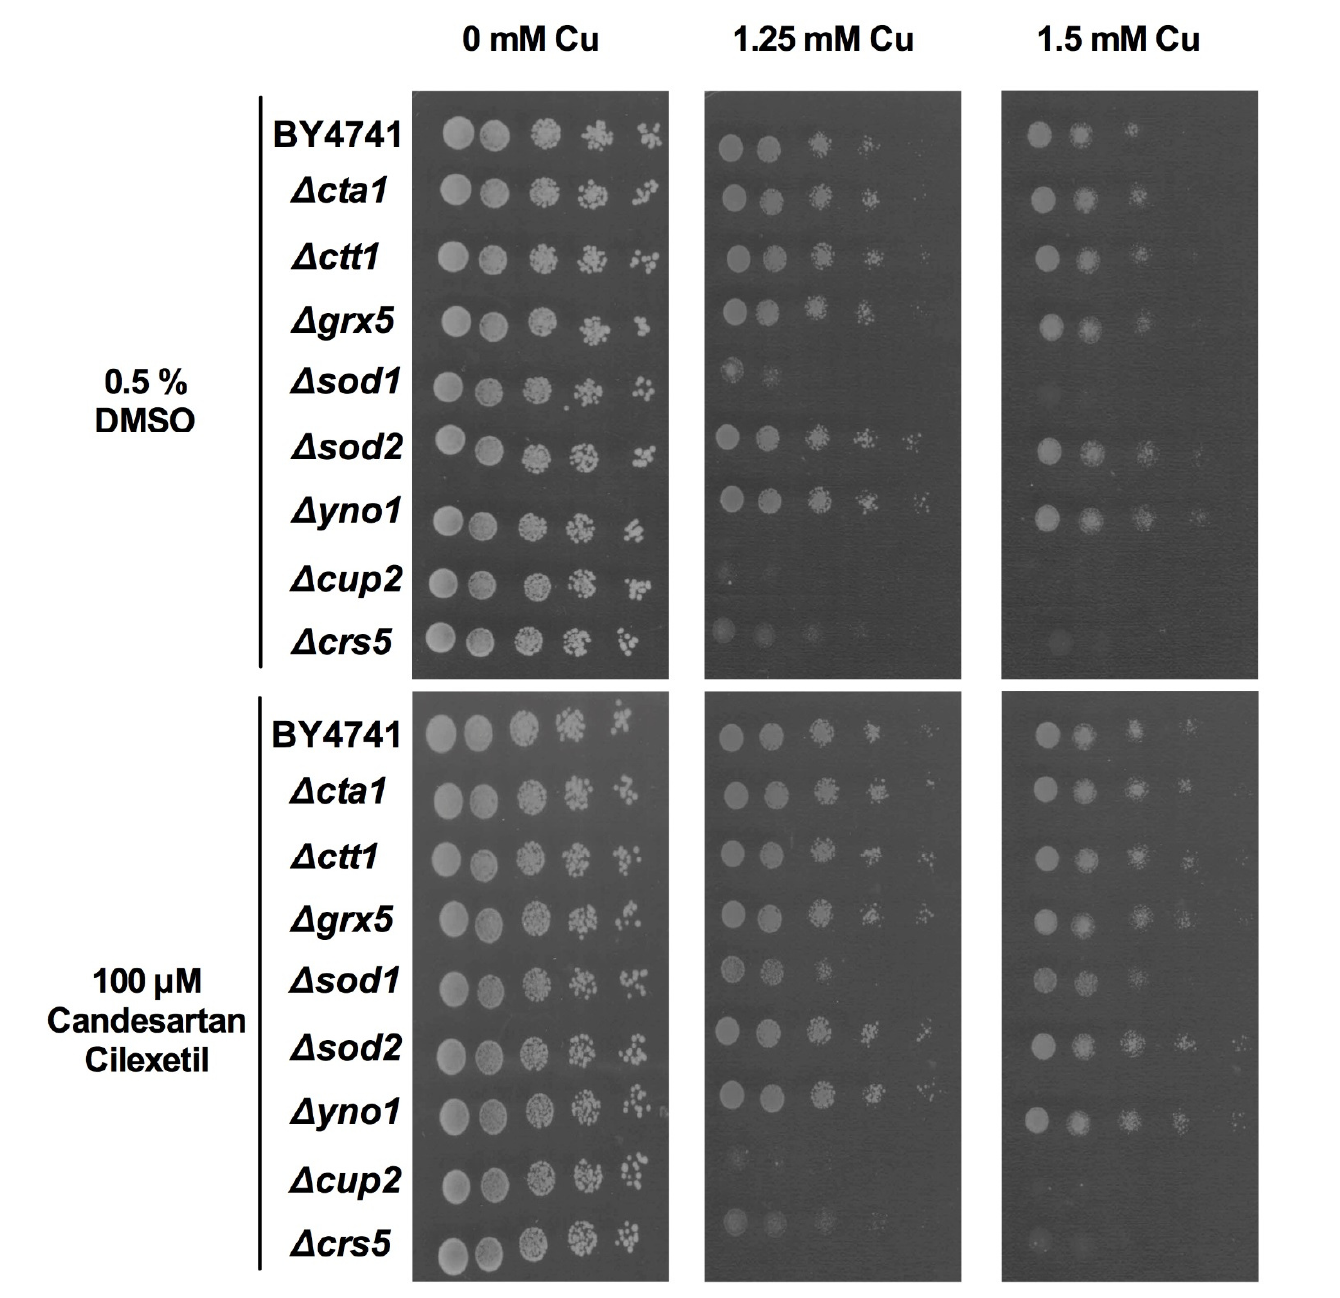
FIGURE 3: Effect of Candesartan Cilexetil on Cu tolerance of yeast mutants. Serial dilutions of wild type (WT), Δ cta1 , Δ ctt1, Δ grx5, Δ sod1, Δ sod2, Δ yno1, Δ cup2 and Δ crs5 were spotted onto control (0 mM Cu) or Cu-containing (1.25 mM – 1.5 mM) solid SC media in presence of control (0.5% DMSO; top panels) or 100 µM Candesartan Cilexetil (bottom panels). Growth was evaluated following 48 h incubation at 30°C. Data representative for two biological